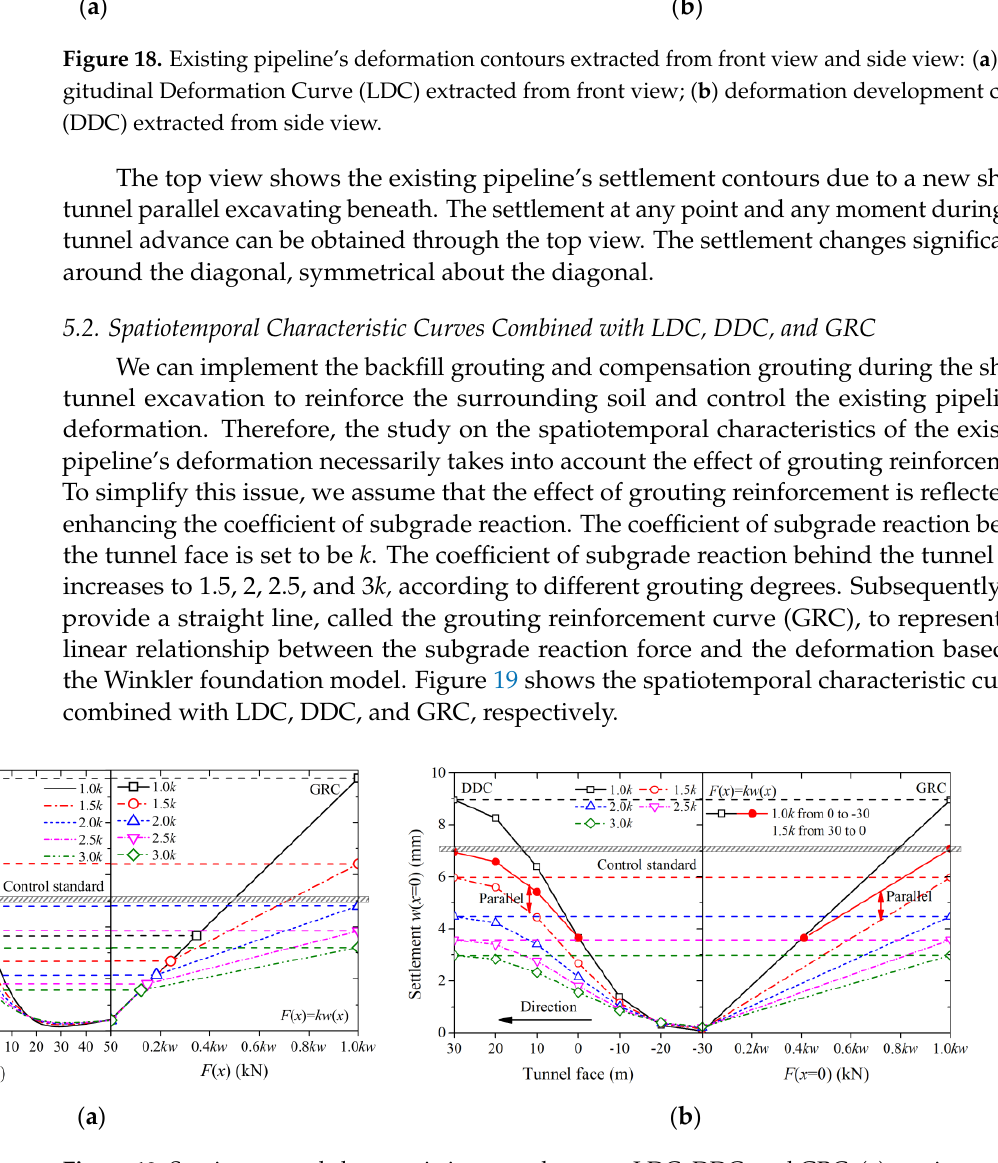
Figure 19. Spatiotemporal characteristic curves between LDC, DDC, and GRC: ( a ) spatiotemporal characteristic curve between LDC and GRC; ( b ) spatiotemporal characteristic curve between DDC and GRC.